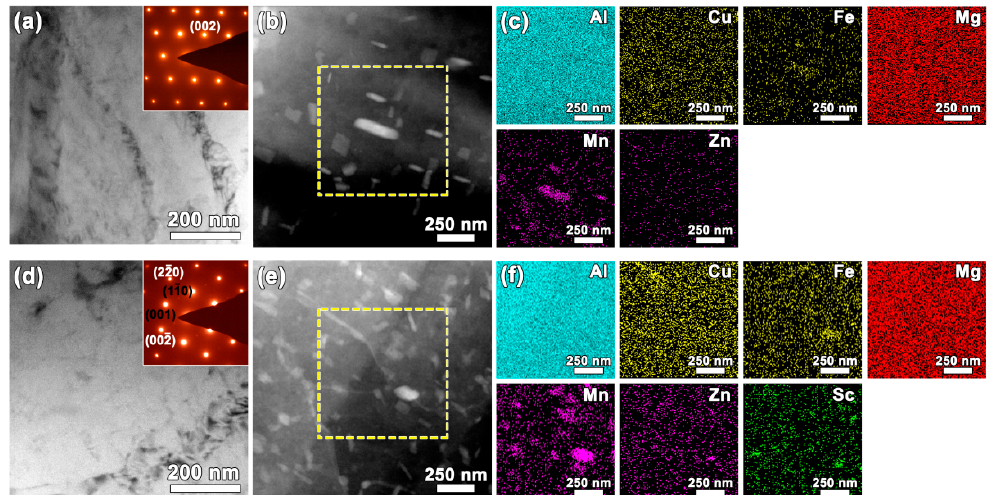
Figure 5. Microscopic structural investigation using TEM for ( a – c ) sample A and ( d – f ) sample B: ( a , d ) typical BF images with the corresponding electron diffraction patterns (insets) and ( b , e ) Z-contrast images with ( c , f ) the corresponding elemental mapping results.